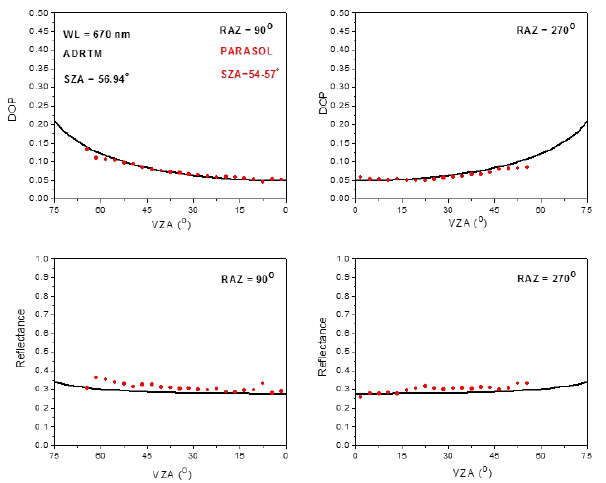
Figure 14. Comparison of the modeled DOP and reflectance of desert-reflected solar light at RAZs of 0 and 180 ◦ with those from the PARASOL data at the wavelength of 865nm. The SZA is 28.77 ◦ in the modeling. The SZA is in the bin of 27–30 ◦ for the PARASOL data.